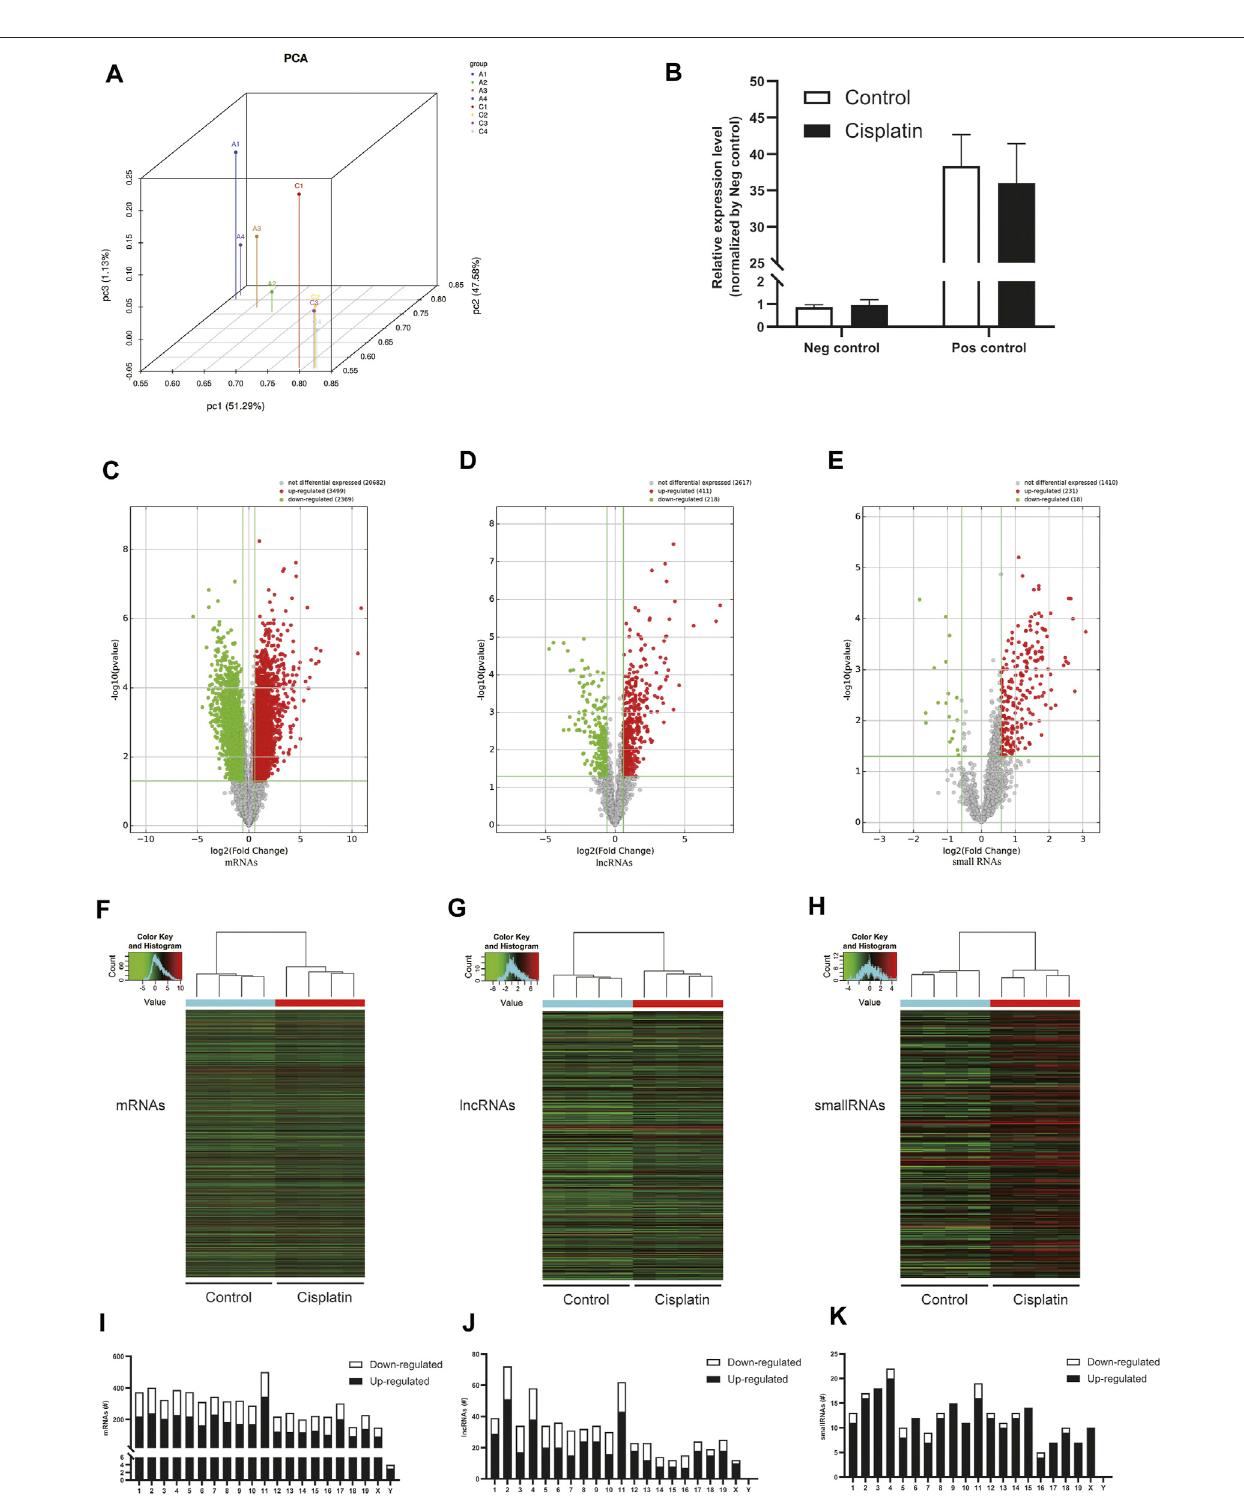
FIGURE 3 | Cisplatin altered m 6 A modi fi cation pro fi les in the kidney. (A) Principal component analysis (PCA) was performed to categorize the differentially m 6 A modi fi ed transcripts between Cis-AKI and control groups (A: Cis-AKI; C: control; n (cid:1) 4 per group). (B) The histogram showing the expression level of positive (Pos) and negative (Neg) spike-in RNA controls that were quanti fi ed by qPCR analysis ( n (cid:1) 4 per group); the volcano plots of mRNAs (C) , lncRNAs (D) , and small RNAs (E) expressions between Cis-AKI groups and control groups are shown. The spots represent upregulated (red) and downregulated (green) expressions of RNAs betweenthetwogroups.Theheatmapsofthedifferentiallym 6 Amodi fi edmRNAs (F) ,lncRNAs (G) ,andsmallRNAs (H) inCis-AKIgroupsandcontrolgroupsareshown. The distributions of altered mRNAs (I) , lncRNAs (J) , and small RNAs (K) among mouse chromosomes are shown.